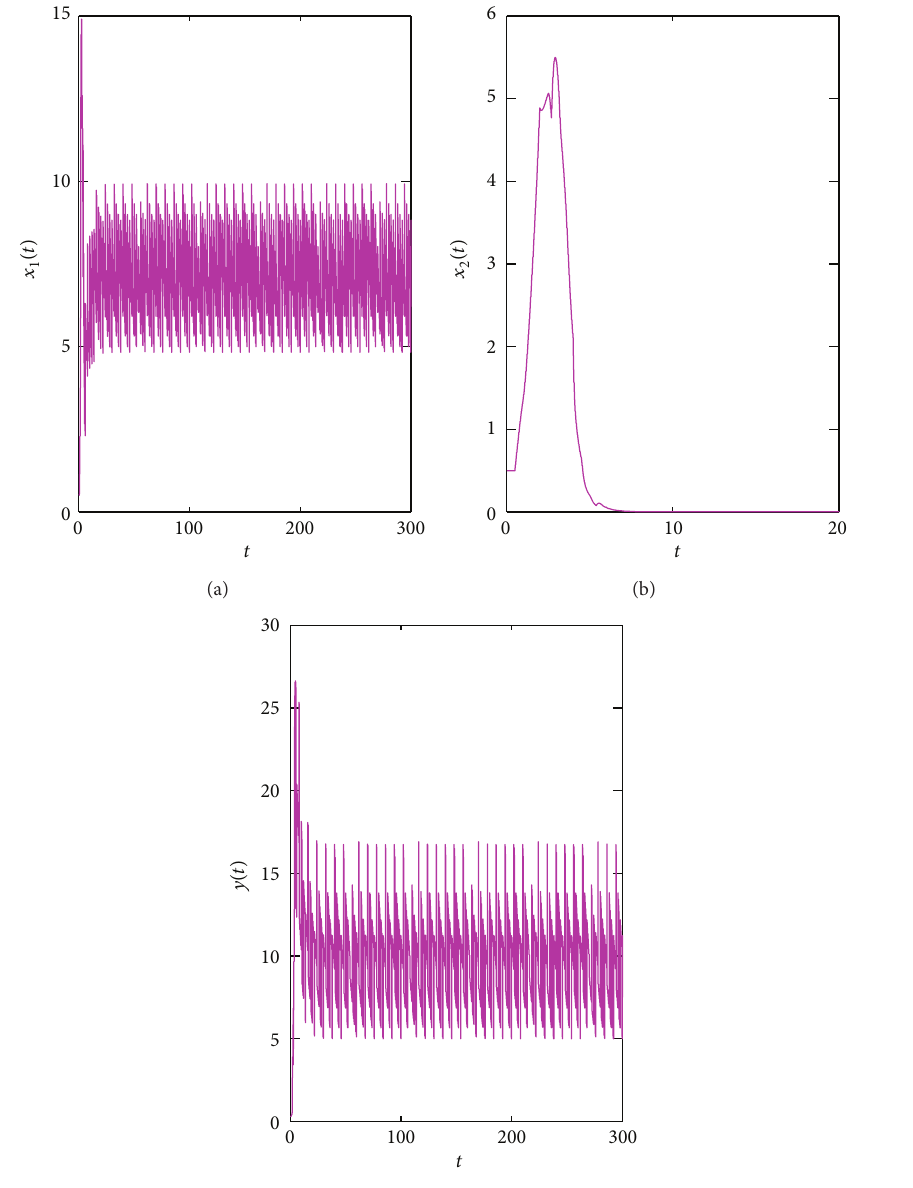
Figure 7: Dynamical behavior of system (22); the parameter values are as follows: 𝑟 = 5,𝜏 = 0.5, 𝜔 = 0.2, 𝛽 = 0.6, 𝑘 = 0.2, 𝑑 1 = 0.15, 𝑑 2 = = 0.1, 𝑝 = 0.2, 𝑝 = 0.5, 𝑎 = 3, 𝑏 = 6,𝑇 = 2, 𝑙 = 0.7 , and 𝜇 = 2 . Here, 𝑅 ∗ 0.2, 𝑑 3 0